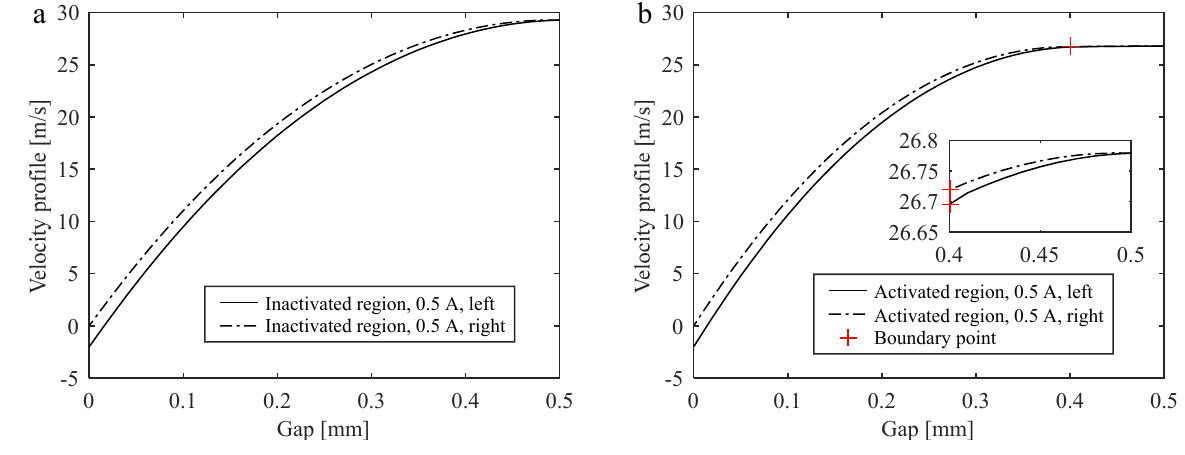
Figure 16. Asymmetry of the velocity profiles for the excitation current of 0.5 A.